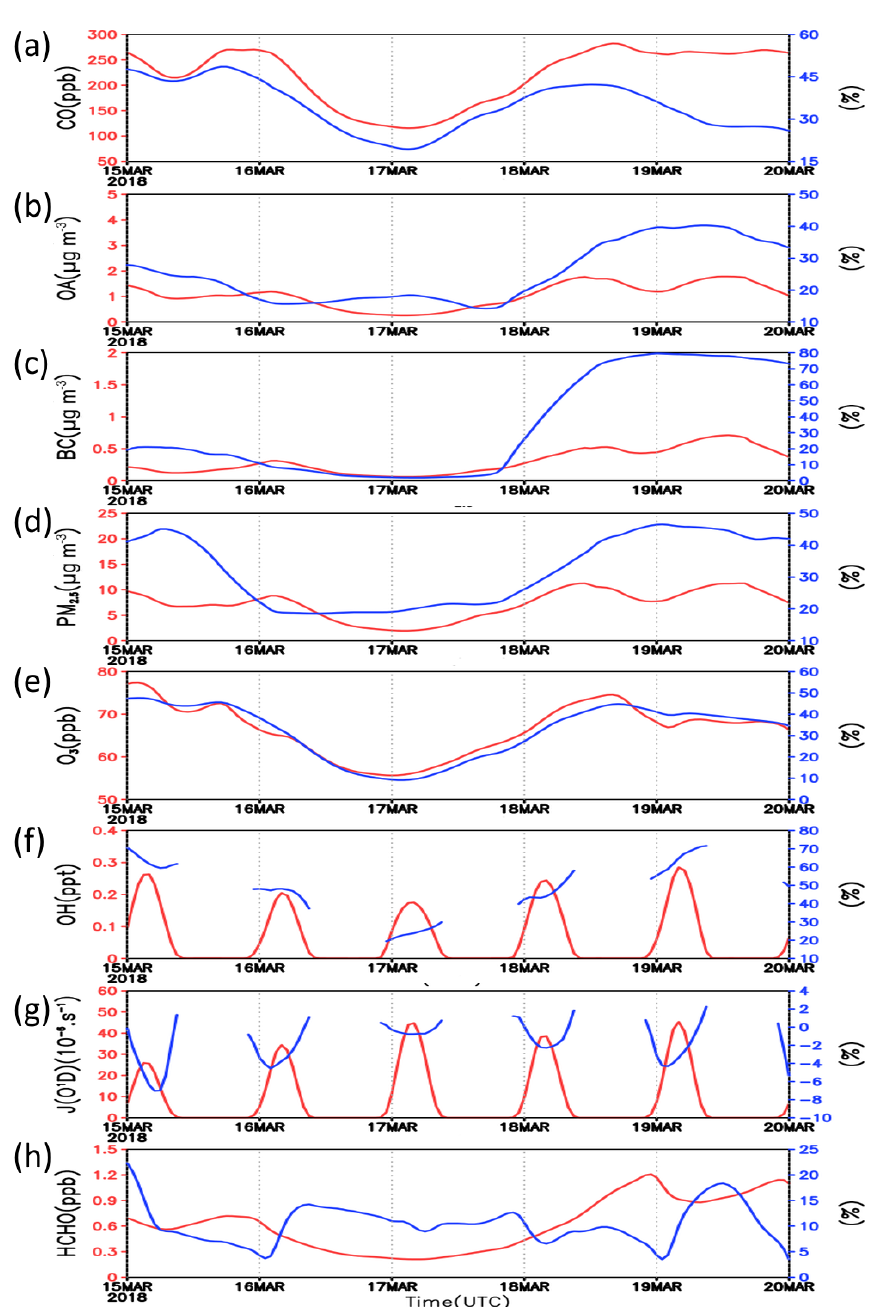
Figure 11. Hourly variation of simulated mean concentration (red) and contribution by BB (%, blue) between 2 and 4km over the region ECSA in Fig. 1a during 15–19 March 2018. (a) CO, (b) OA (c) BC, (d) PM 2 . 5 , (e) O 3 , (f) OH, (g) J (O 1 D), and (h)